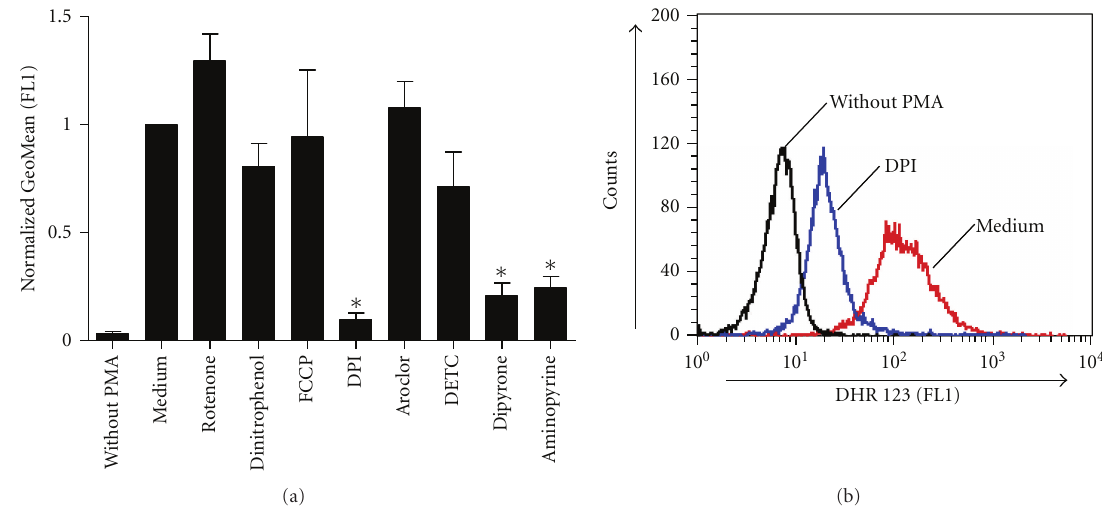
Figure 3: Flow cytometry analysis of intracellular ROS production by neutrophils after exposure to various inhibitors. Freshly isolated human neutrophils were incubated with or without inhibitors (10 µ M Rotenone, 10 µ M Dinitrophenol, 500 nM FCCP, 20 µ M DPI, 38 µ M Aroclor, 10 µ M DETC, 200 µ M Dipyrone, and 200 µ M Aminopyrine) for 30 min at 37 ◦ C. Cells were loaded with DHR 123, and the samples were stimulated with 4 µ M PMA. The intracellular production of ROS was assessed by using flow cytometry. (a) Geometrical mean (GeoMean) values of the fluorescence intensities normalized to the PMA-induced ROS production in the absence of inhibitors (Medium). Data show mean ± SD from four independent experiments, ∗ : P < 0 . 001 as compared to the PMA-stimulated sample without inhibitor (Medium). (b) Representative histogram showing the fluorescent intensities of unstimulated neutrophils (without PMA), PMA-stimulated neutrophils without inhibitor (Medium), and, as an example for an inhibitory e ff ect, PMA-stimulated neutrophils after exposure to DPI. Data are from one experiment representative for three independent experiments.